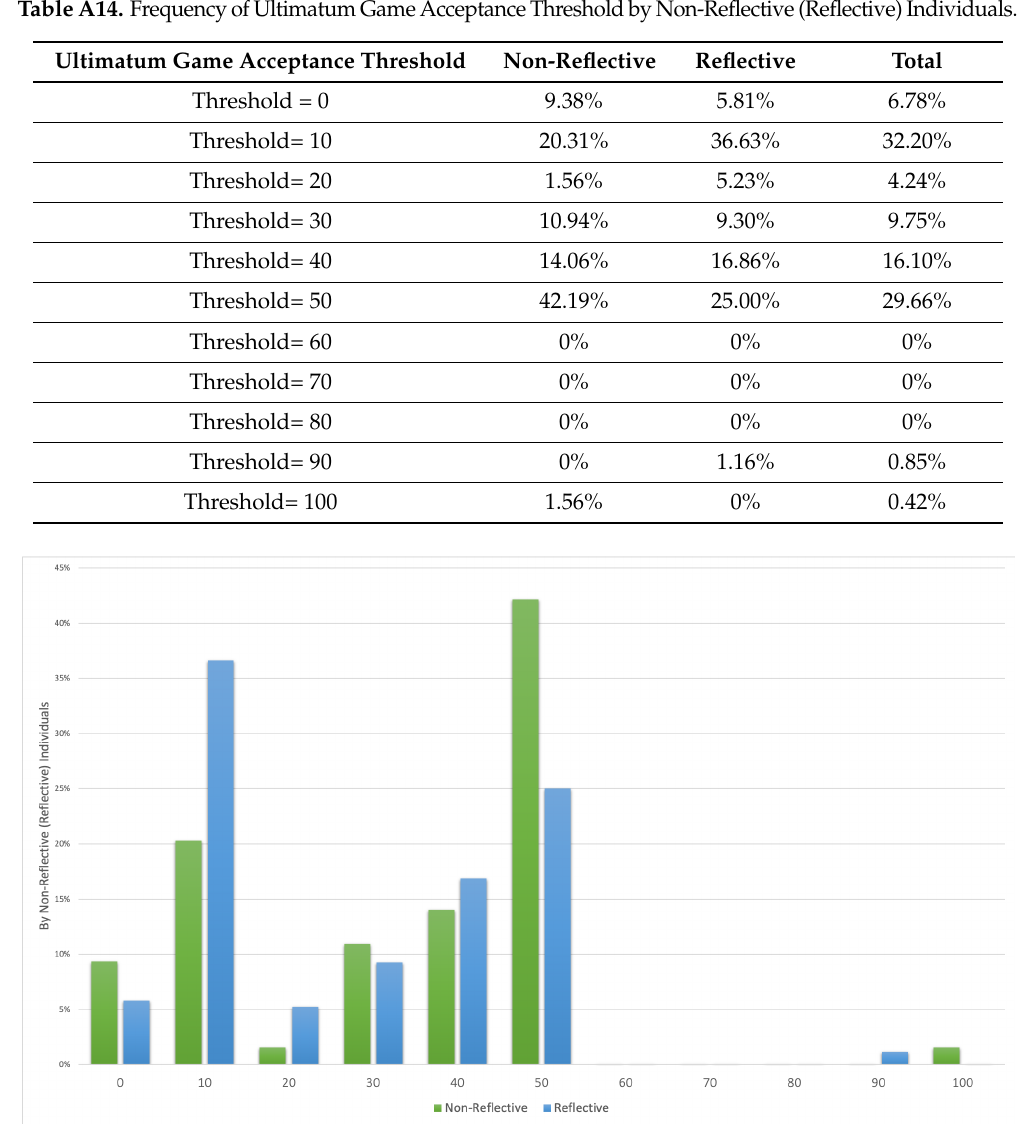
Figure A8. Frequencyof Ultimatum Game Acceptance Threshold by Non-Reflective(Reflective)